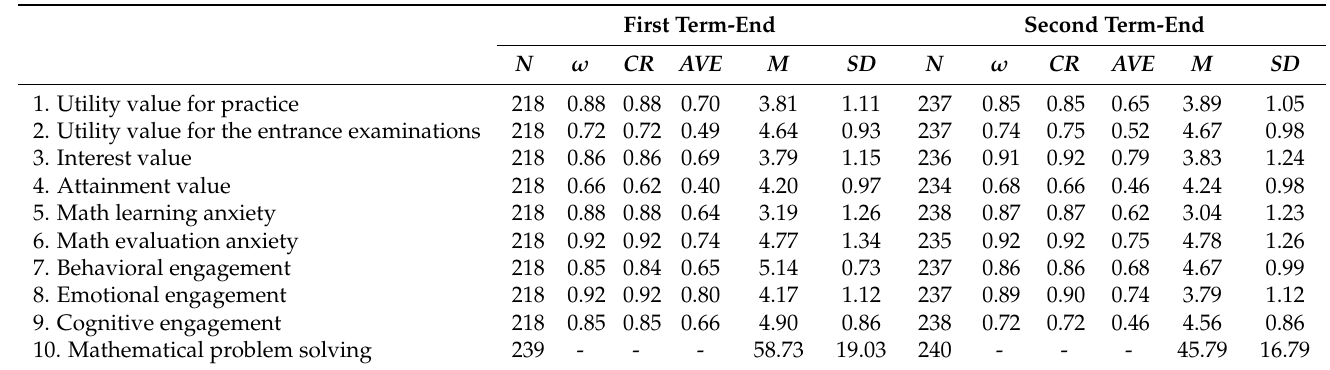
Table 2. Descriptive statistics for task value, math anxiety, engagement and mathematical problem solving.